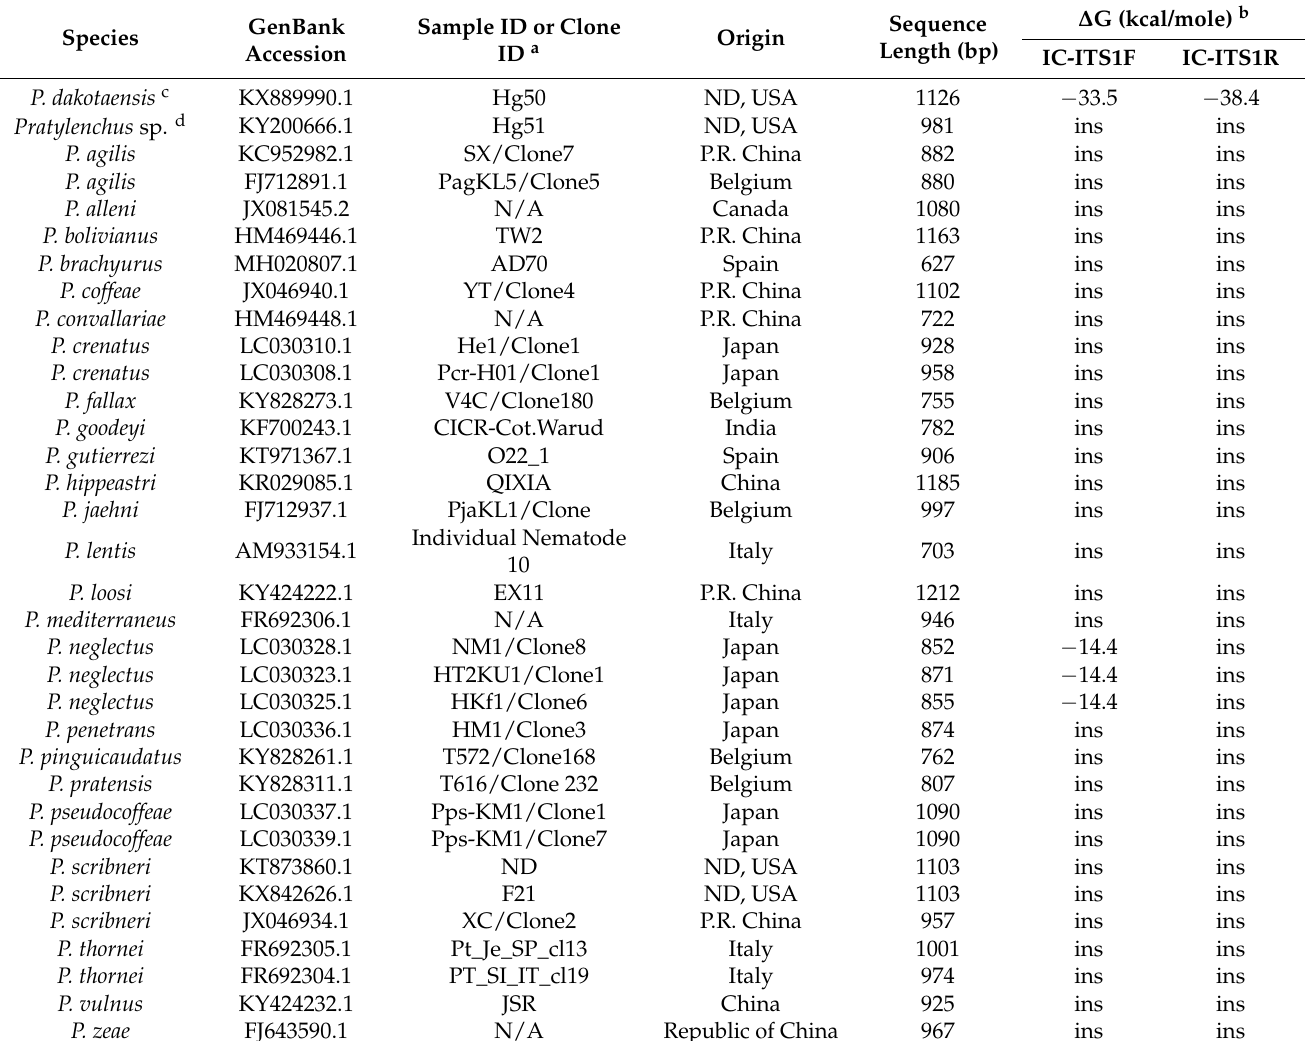
Table 1. Populations of Pratylenchus spp. and their corresponding GenBank accession numbers of internal transcribed spacer (ITS) sequences used for analysis of primer-template duplex stability ( ∆ G) for predicting the specificity of primers, IC-ITS1F and